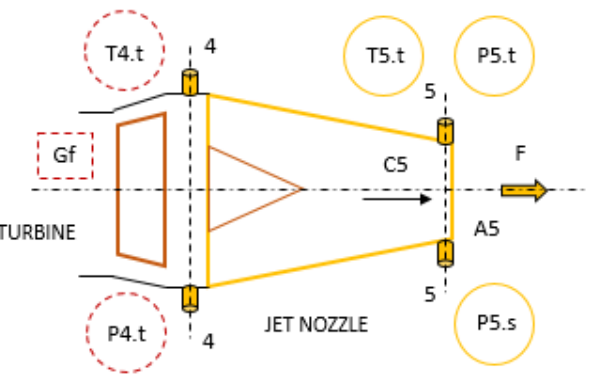
Figure 4. Jet nozzle instrumentation method scheme.